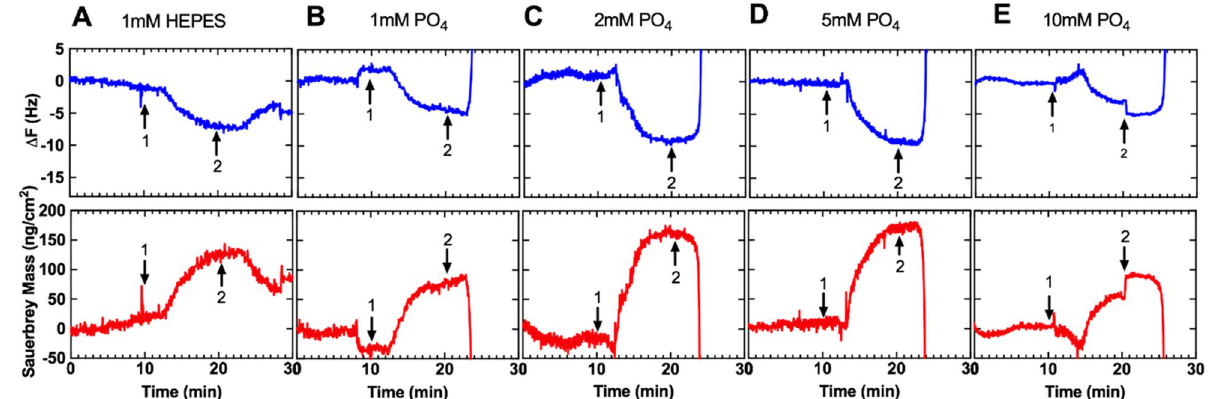
Figure 7. Influence of phosphate on Teic detachment from TiO 2 . Ti-QCM sensors were subjected to HEPES buffer (50 mM; pH 7.4) at a flow rate of 100 µl/min at 21 °C for 10 min prior to 500 µg/ml Teic in HEPES for 10 min (arrow 1). Coated Ti-QCM sensors were then washed for a final 10 min with either ( A ). HEPES or PBS with ( B ). 1 mM, ( C ). 2 mM, ( D ). 5 mM or ( E ). 10 mM phosphate concentrations (arrow 2). Representative plots from triplicate (N = 3) experiments showing change in fundamental frequency (upper panels) and calculated Sauerbrey mass (lower